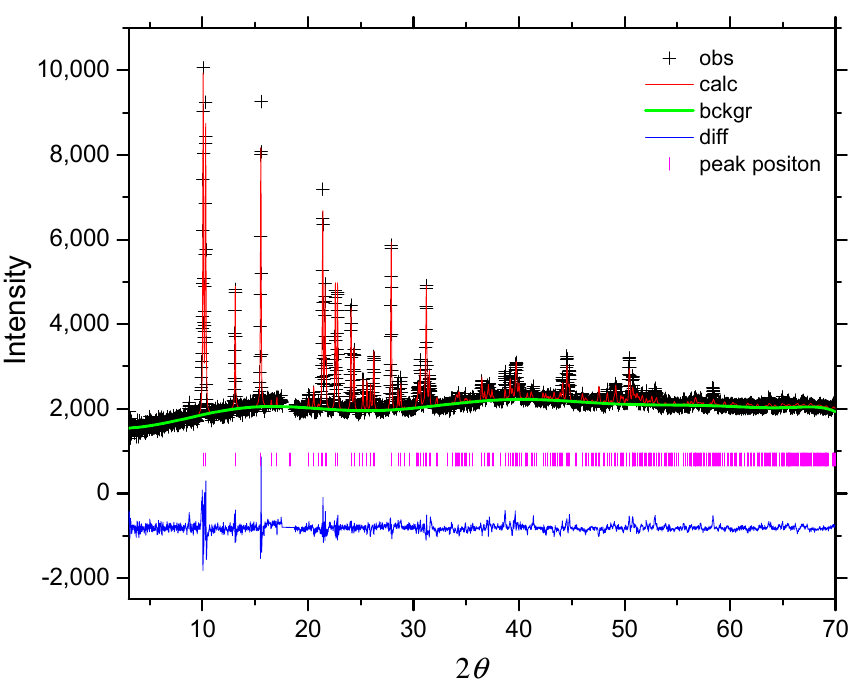
Figure 2. Rietveld plot (PXRD, CuK α 1) for 3 . The Teflon peak near 2 θ ~18° has been excluded from the refinement.